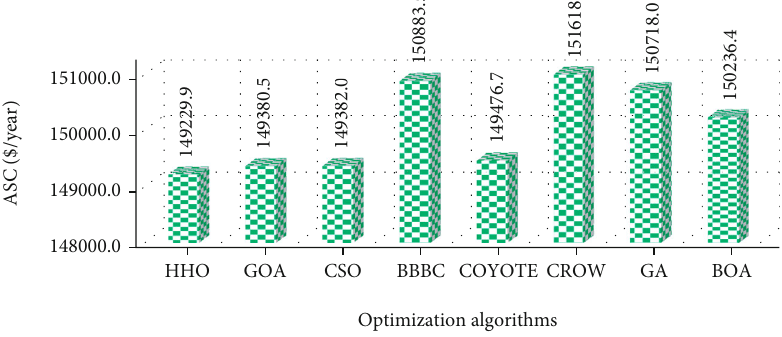
Figure 4: The optimal ASC utilizing HHO when compared to the other seven metaheuristic